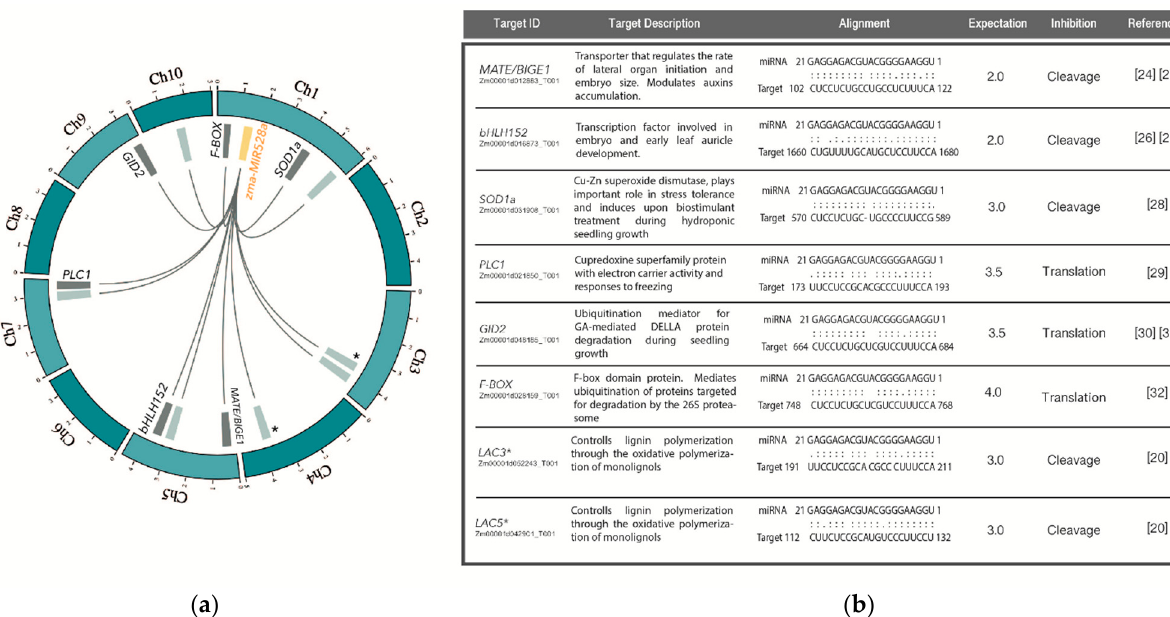
Figure 1. Target prediction for zma-miR528. ( a ) Circos plot between zma-miR528a and predicted targets showing their chromosomal location. The yellow-filled box represents the MIR 528a gene location. Gray dark boxes refer to targets selected and analyzed in this study. For Circos plot construction, we used zma-MIR528a location only to illustrate the miRNA-target pairing, as both genes produce the same mature miRNA targeting the same transcripts. Pale gray boxes denote other putative targets not approached in our investigation. (*) Experimentally validated targets for zma-miR528 in a previous report: ZmLAC3 (Zm00001d052243_T001); ZmLAC5 (Zm00001d042901_T001). ( b ) List of the selected potential targets showing the recognition site pairing for zma-miR528 and their reported function in plant pathways according to several reports [19,23–31] .